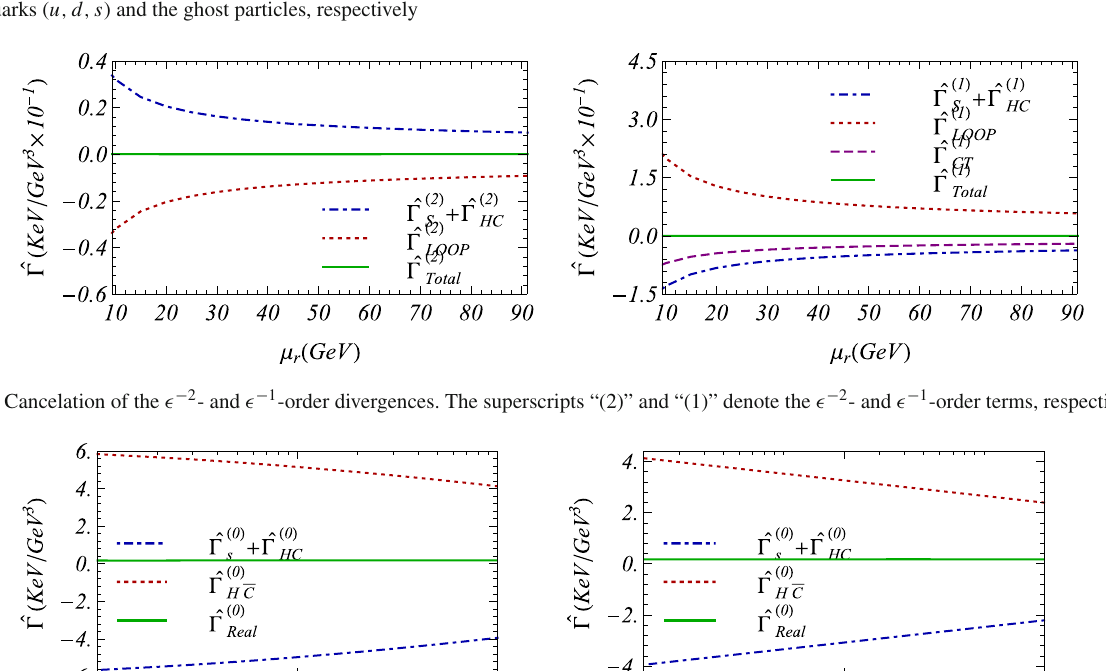
] + g + g . The superscripts “ q ” and “ u g ” denote the 1